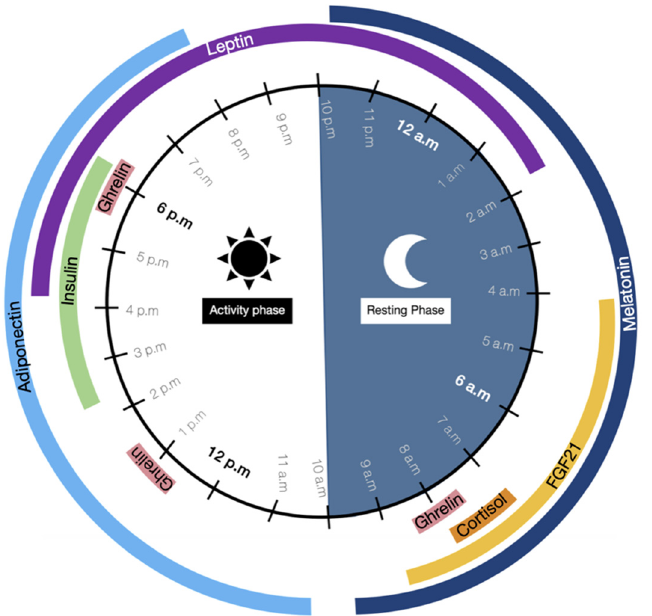
Figure 1. Time-of-day-dependent patterns of circulating hormone levels variation. Circadian rhythms are driven by oscillations of endocrine factor levels during the day. These variations are important to perform physiological processes at the optimal time of the day. Melatonin induces the resting phase whereas cortisol prepares the body for the activity phase. The other hormones drive modifications of glucose and lipid metabolism, promoting either catabolism with fatty acid oxidation and glycolysis (FGF21, adiponectin, leptin) or anabolism with lipogenesis and glycogen- esis